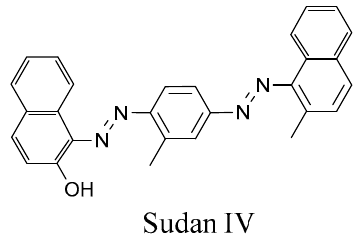
Figure 7. Methyl Orange (please, refer to Figure 6) and Sudan IV have been the subject of a comparative bleaching study by dichloro- or dibromophenyl meso -substituted Mn porphyrins.